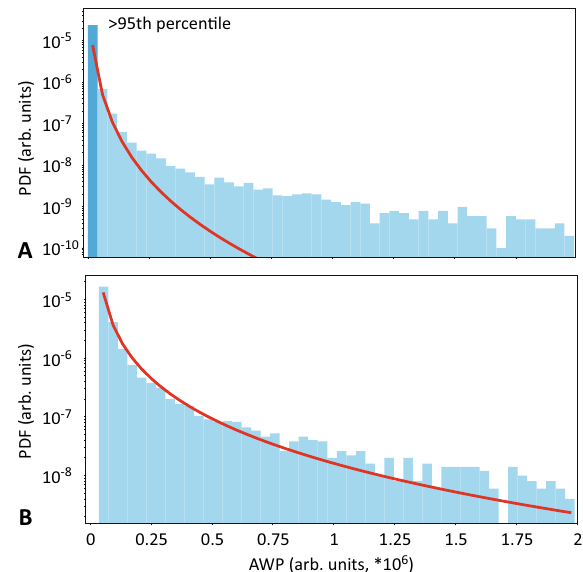
norm Figure 1. PDF of E ( t ) for one subject for: ( A ) the whole dataset and ( B ) above 95th percentile subset; dark blue histogram shows below 95th percentile subset, blue histogram—above 95th percentile subset; the Weibull approximations are shown as red